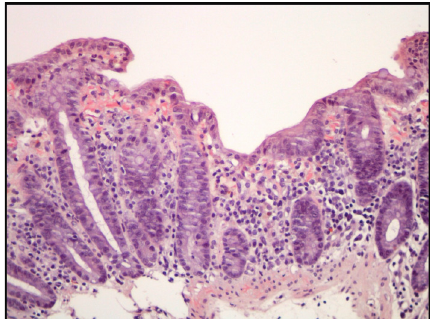
Figure 2: Colon biopsy. Fragment of mucosa from the distal portion of the intestine with conserved general architecture. De- posits of amyloid substance predominantly subepithelial and perivascular, positive for Congo red